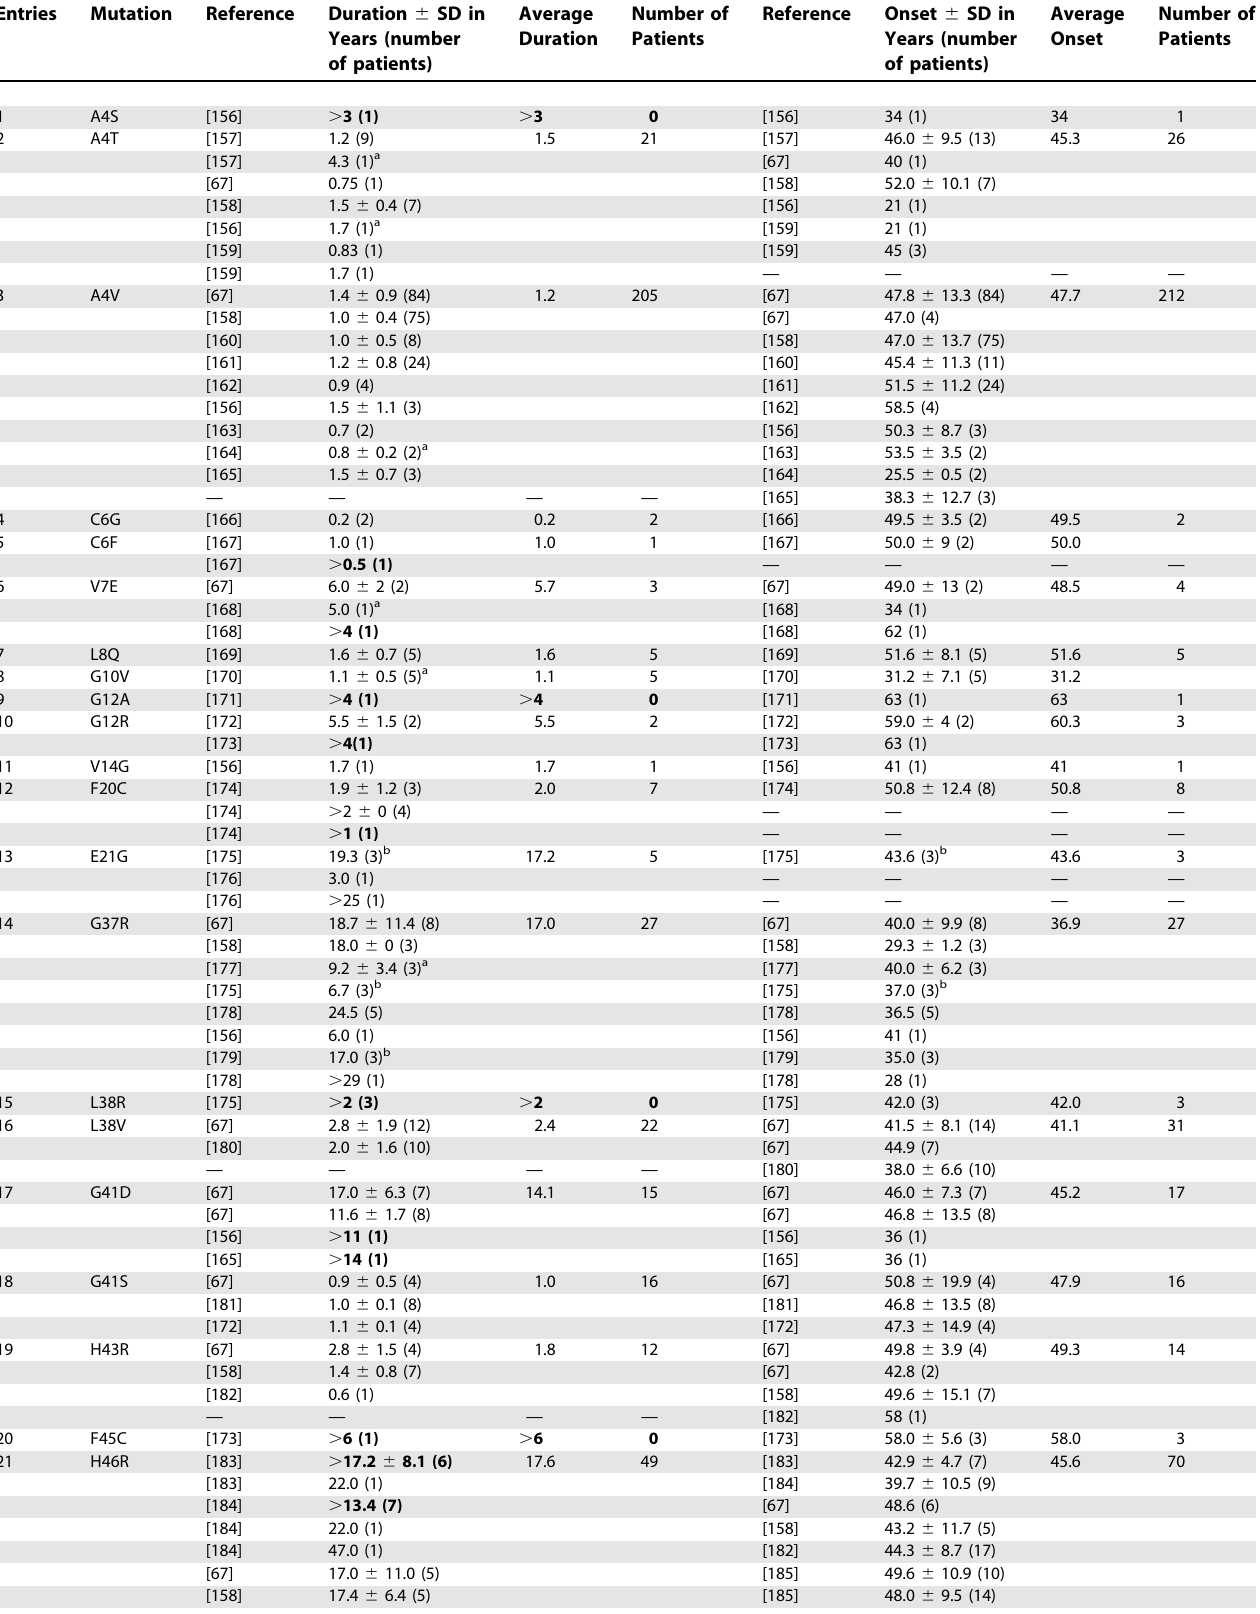
Table 6. Disease Durations and Age of Onsets for SOD1 Mutation Related fALS, Non-SOD1-Related fALS, and sALS Patients Entries